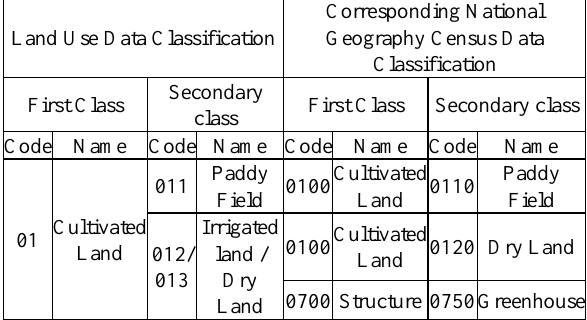
Table 1. Correspondence of two types of data (cultivated land)